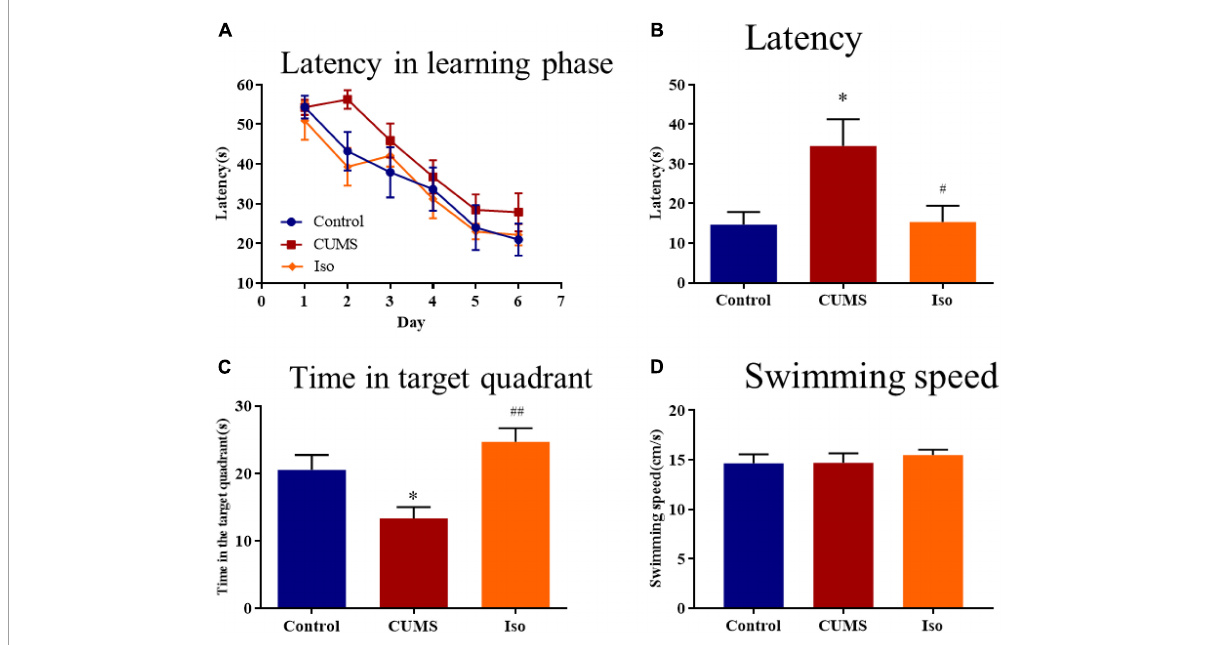
FIGURE3 Effects of isorhynchophylline on the spatial memory in MWM test in CUMS mice. (A) The escape latency of mice in learning phase. (B) The escape latency in probe trial was significantly decreased by isorhynchophylline in CUMS mice. (C) The time spent in the target quadrant was significantly increased by isorhynchophylline in CUMS mice. (D) There was no difference in swimming speed in each group. The data are presented as mean ± SEM. ∗ P < 0.05 compared to the con group; # P < 0.05, ## P < 0.01 compared to the CUMS